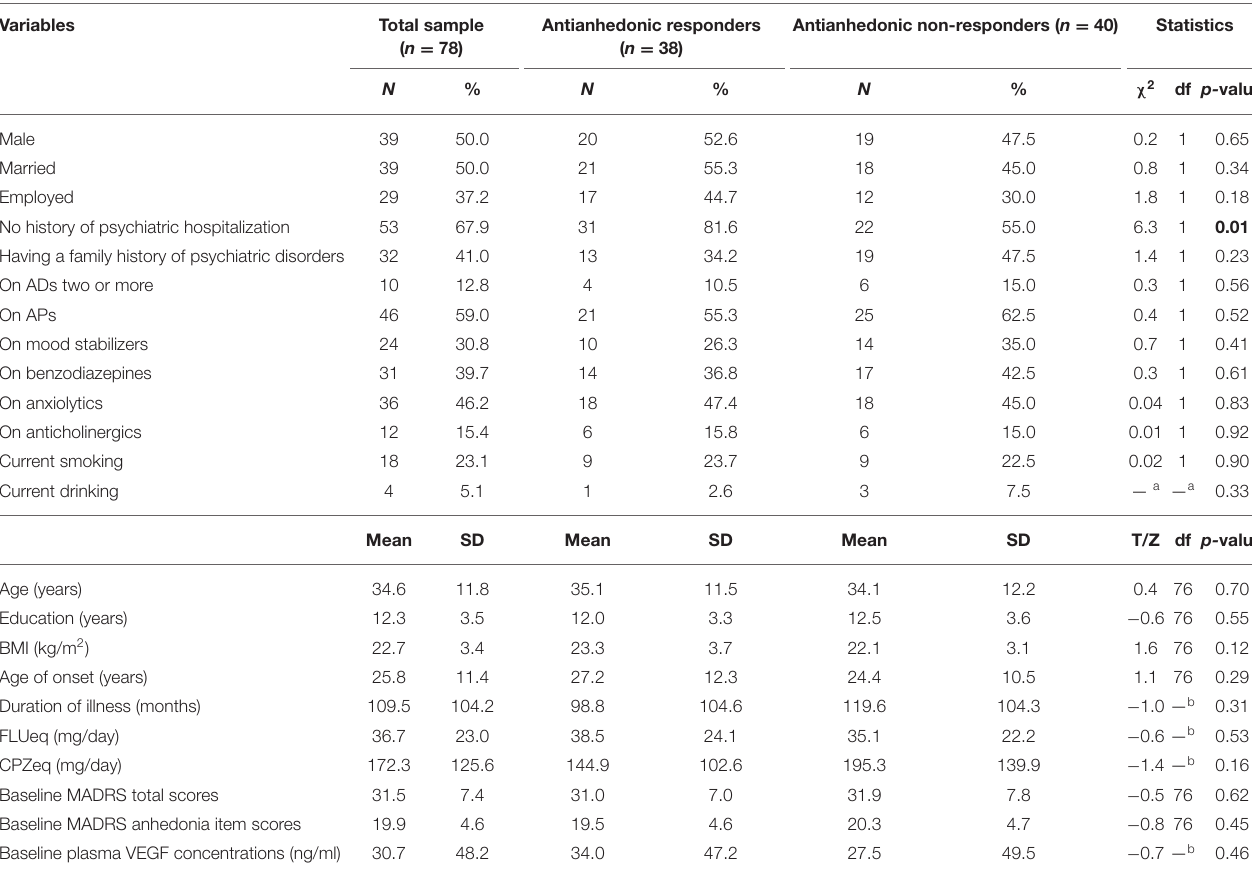
TABLE 1 | Demographic and clinical characteristics of subjects suffering from TRD. Variables